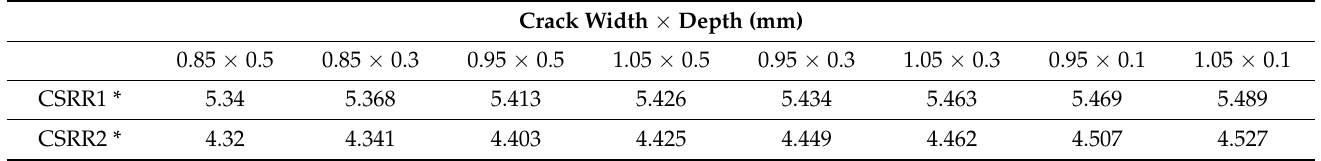
Table 3. Proposed sensor performance for each